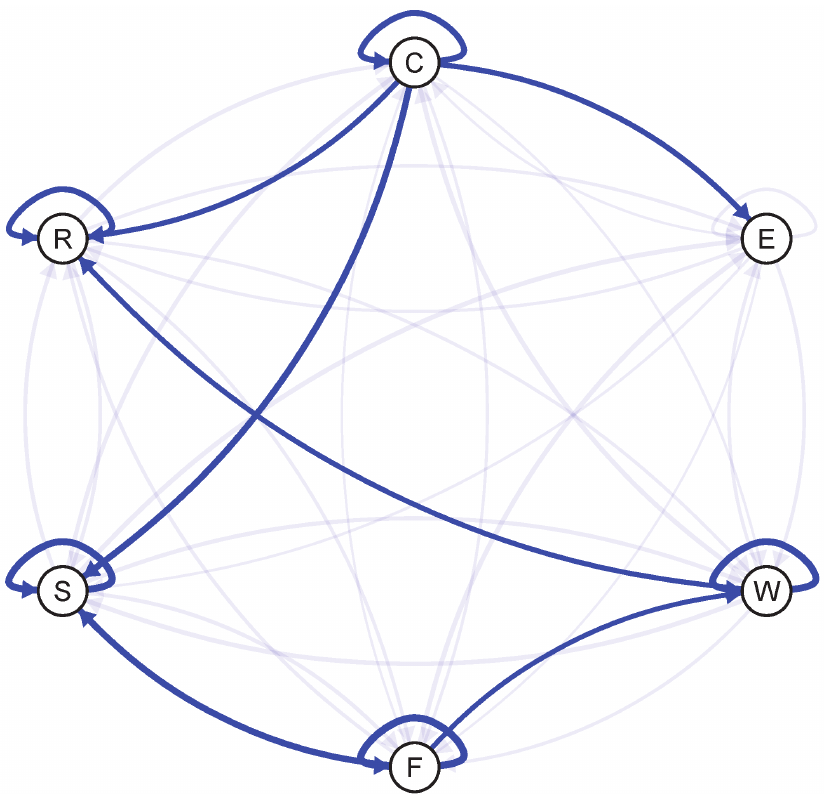
Figure 2. Inter-individual differences of the arrows of the network from Figure 1. The thickness of the arrows is based on the size of the standard deviation of the random effects. To construct the figure, we have put a cutoff of 0.1 on the standard deviation and only the standard deviations above the cutoff are shown with a non-transparent arrow. As the threshold for the standard deviation of the random effects 0.1 was chosen because it represents large inter-individual differences. The average coefficient of the self-loops (i.e., autoregression coefficients) is about 0.2 with a random effects standard deviation of 0.1. Therefore, assuming a normal distribution, the range from 0 to 0.4 represents 95% of the individual self-loop coefficients. With a larger cutoff, such as 0.2, also individuals having negative self-loops would be taken into account. However, more than 95% of the population has a positive self-loop strength. The arrows in the network now represent the estimated variance of the relevant VAR parameters over individuals. Only Figure 2. For example, the pronounced self-loop on the item ‘worry’ indicates a high individual variability.